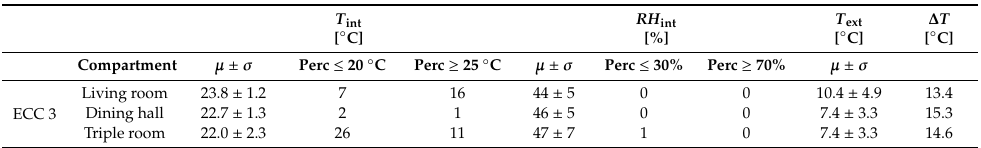
Table 13. Statistical analysis of hygrothermal parameters recorded in compartments of ECC 3 : 1 st trial (February–March).